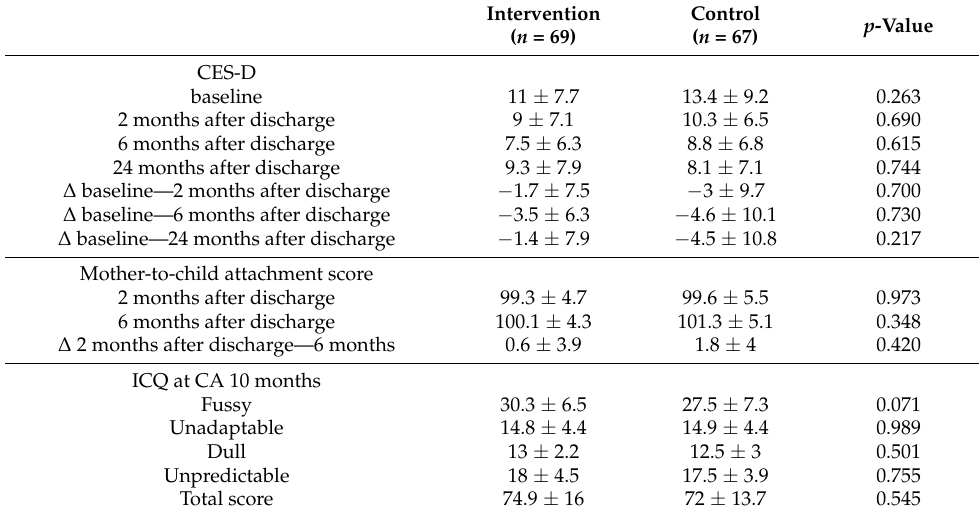
Table 3. CES-D, mother-to-child attachment score, and